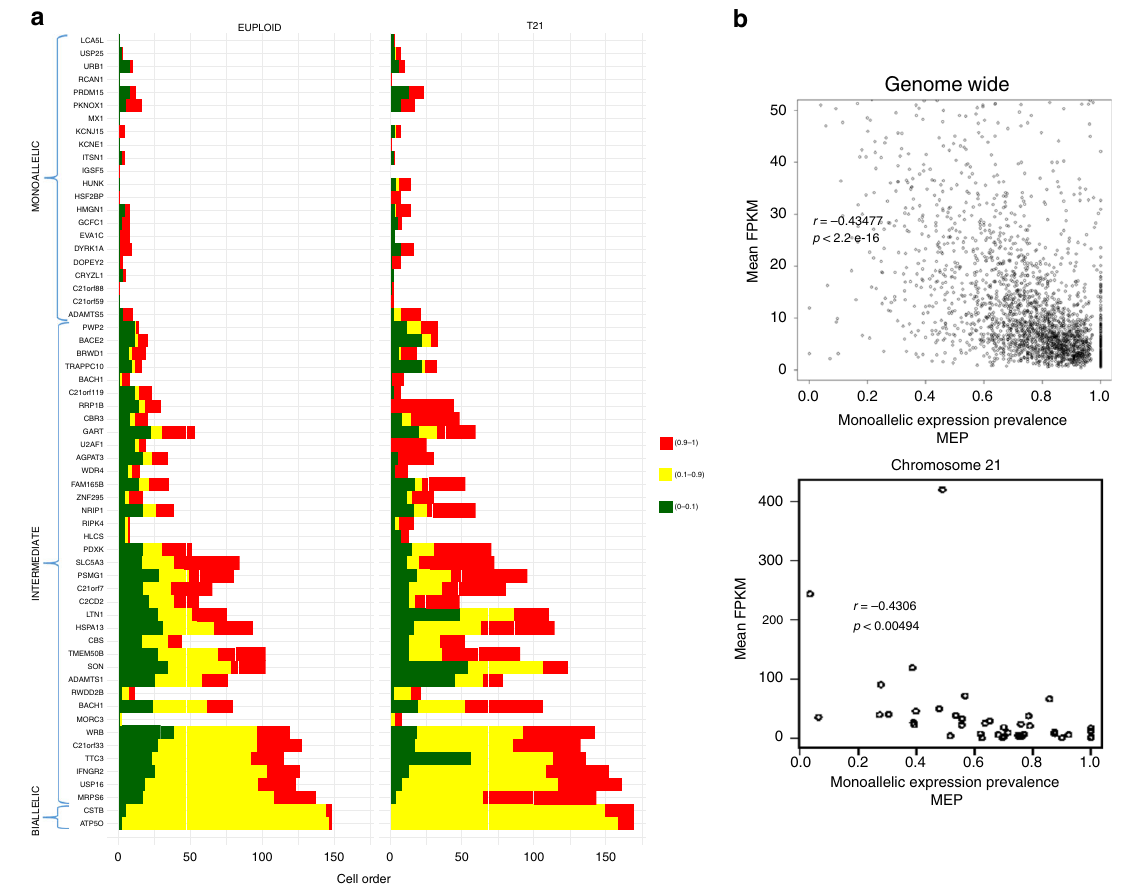
Fig. 3 Prevalence of monoallelic expression in supernumerary chromosomes. a Classi fi cation of genes in three groups (Monoallelic, Intermediate, and Biallelic). Genes for which >80% of cells show monoallelic expression were classi fi ed as monoallelic (ASE ≤ 0.1 or ASE ≥ 0.9); genes with 20 – 80% of cells with 0.1 ≤ ASE ≤ 0.9 were classi fi ed as intermediate; genes with <20% of cells with 0.1 ≤ ASE ≤ 0.9 were classi fi ed as biallelic. b Monoallelic prevalence is negatively correlated with level of gene expression both genome-wide (diploid fraction of the genome — upper panel) and within the trisomic fraction of the genome (chr21 — lower panel). Source data are provided as Source Data fi